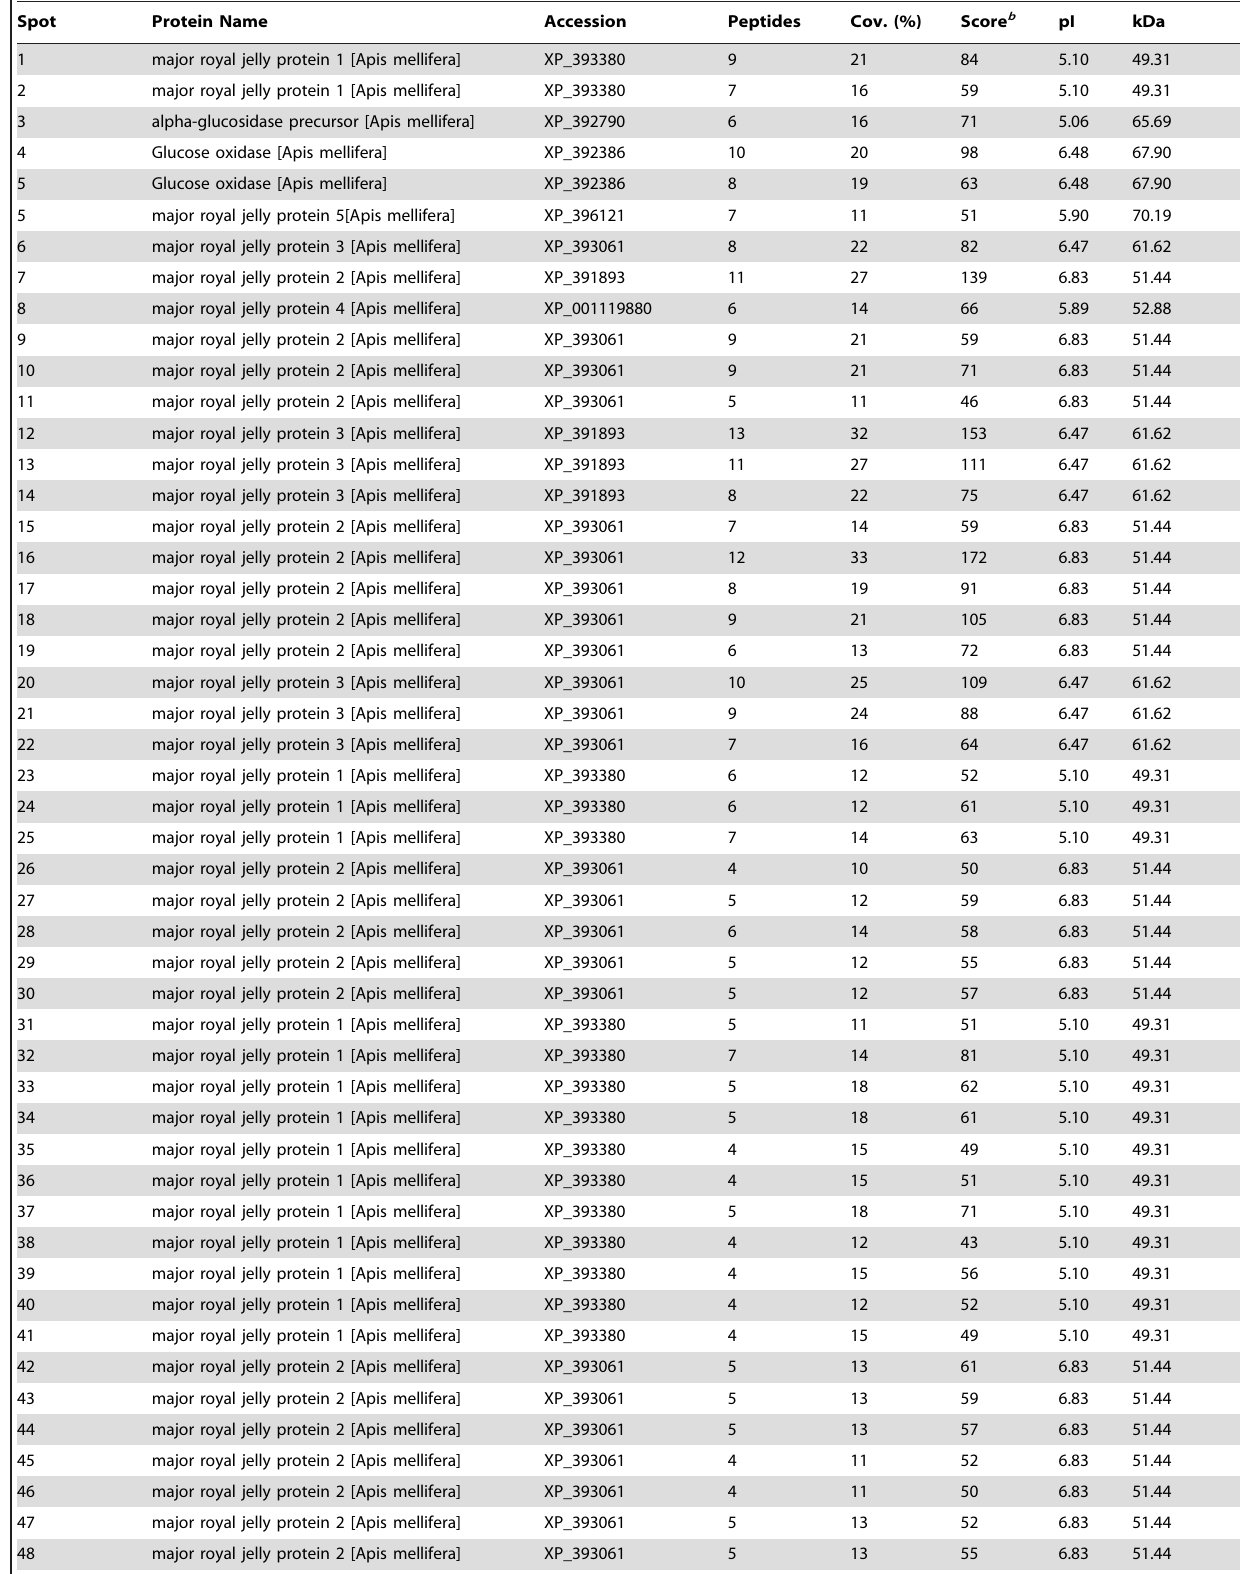
Table 3. Protein identification in the honey eucalyptus MT1 extract a